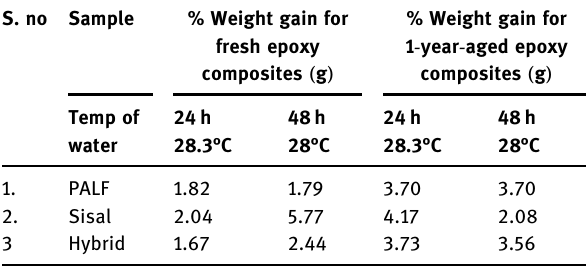
Table 2: Water absorption behavior of various composites